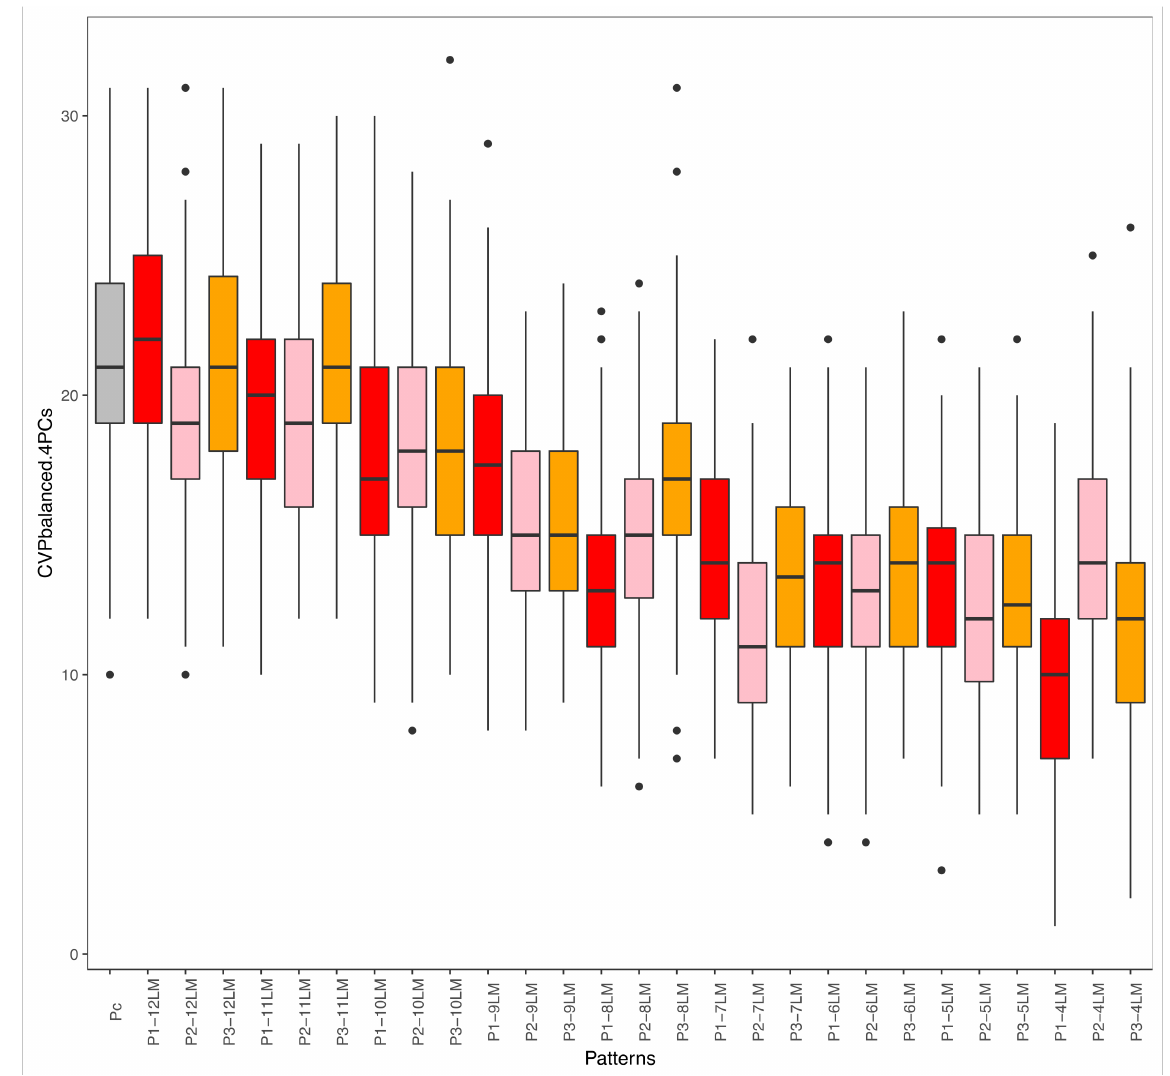
Figure 5. Boxplot representing the distribution of cross-validation percentages (CVP) for 4 PCs of each pattern (between 4 and 12 landmarks), according to the genus of attribution of specimens from the reference collections. Grey: Pc: complete protocol, Red: P1: category of the first most frequent fragmentation patterns with N landmarks, Pink: P2: second category, Orange: P3: third